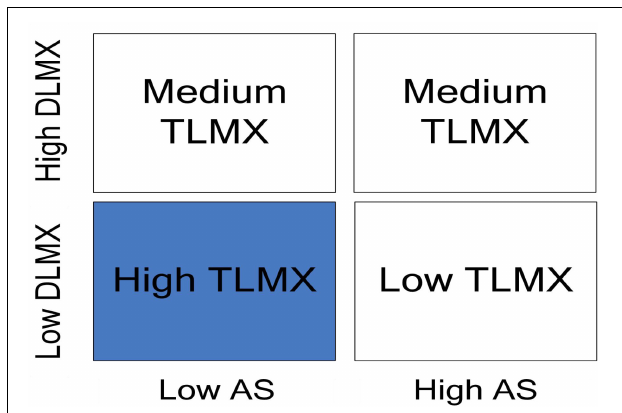
FIGURE 2 | Hypothesized interaction effects of abusive supervision and DLMX on TLMX.